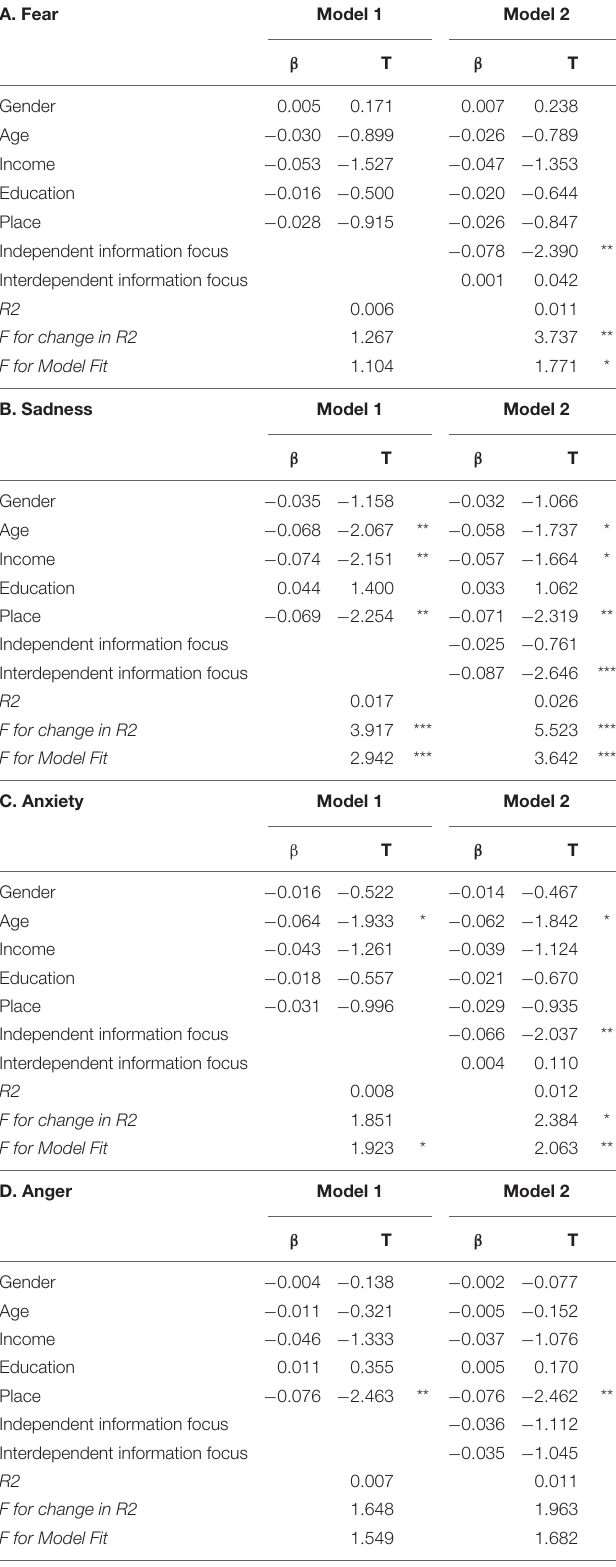
TABLE 3 | Effects of coping strategies on the change of each